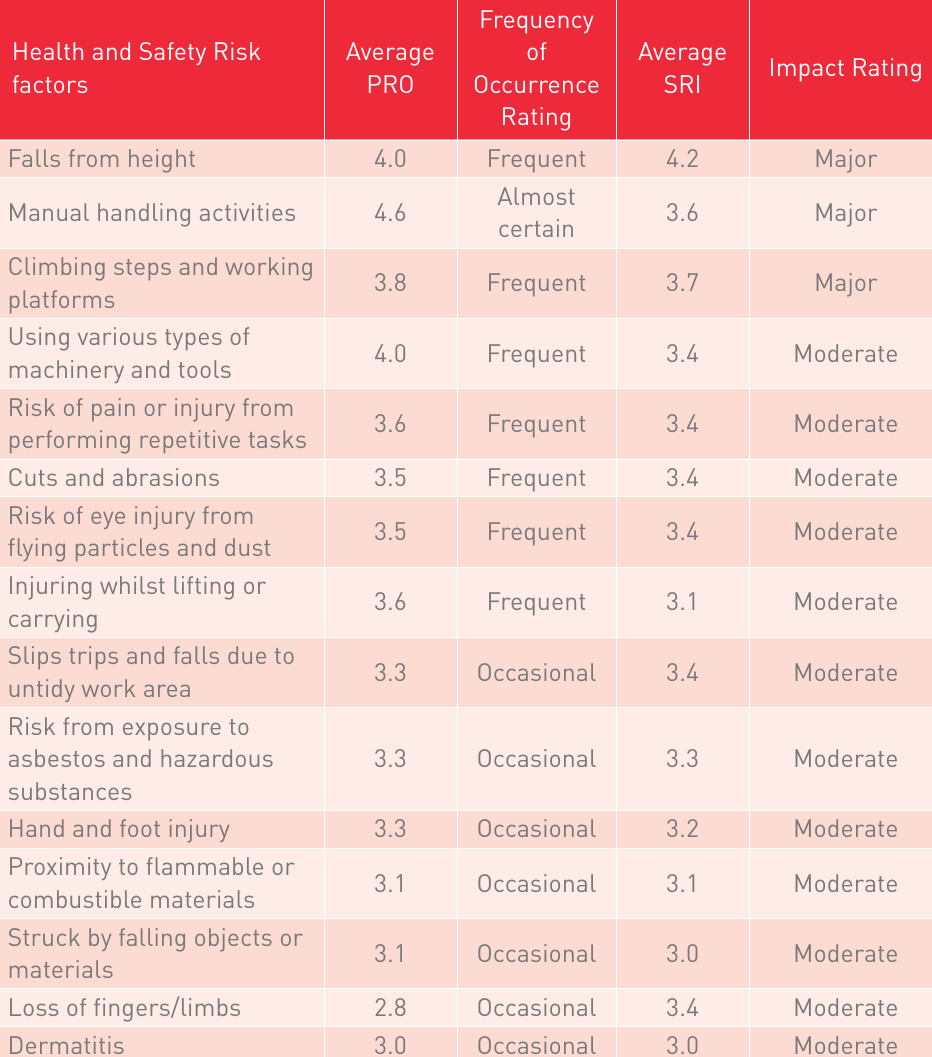
Analysis of frequency and impact of health and safety risk factors in building